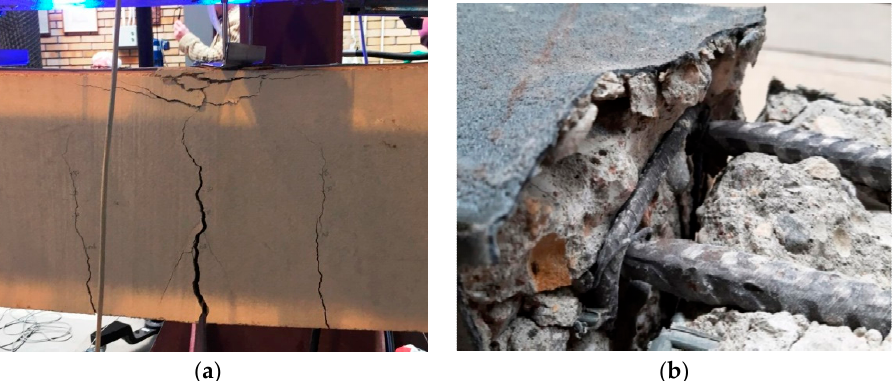
Figure 14. Failure mechanisms of the RC beams: ( a ) A beam without the polyurea coating; ( b ) A polyurea-coated beam.